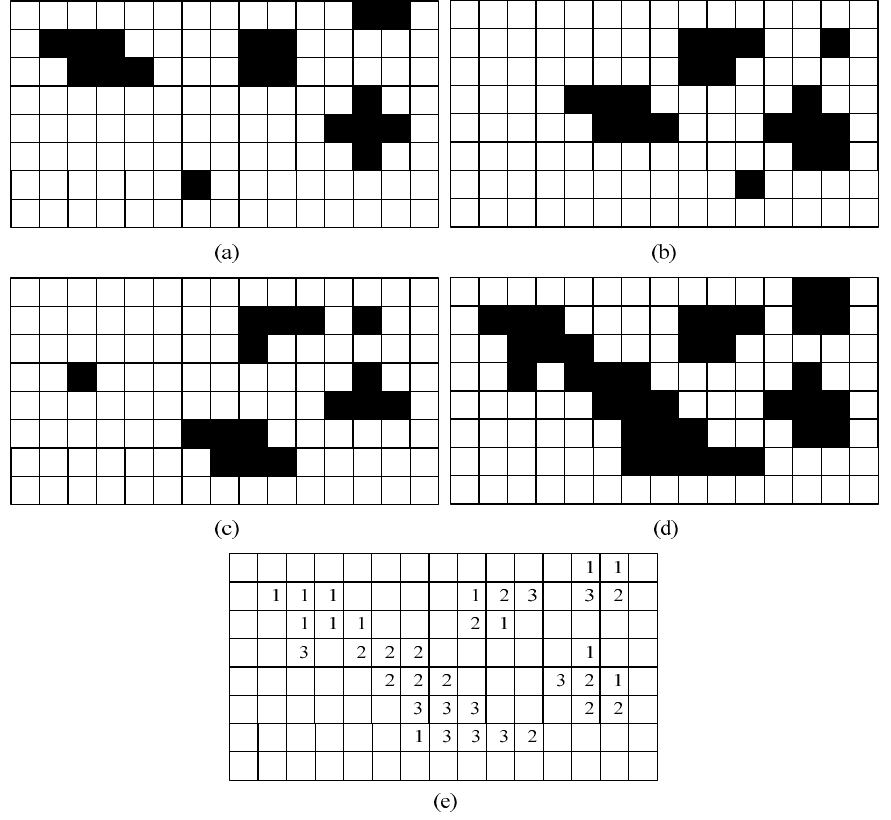
Figure 4. Schematic diagram of the maximum projection principle. ( a ) First frame image. ( b ) Second frame image. ( c ) Third frame image. ( d ) The motion of the target is connected after the maximum projection. ( e ) The time labels generated by the maximum projection at the same time.